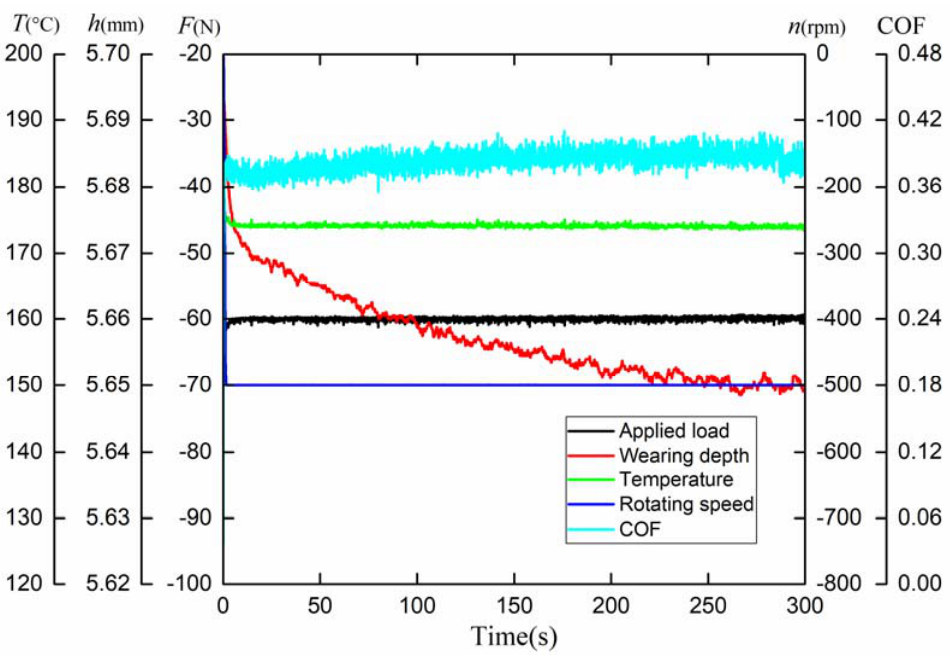
Figure 3. Representative test signals.